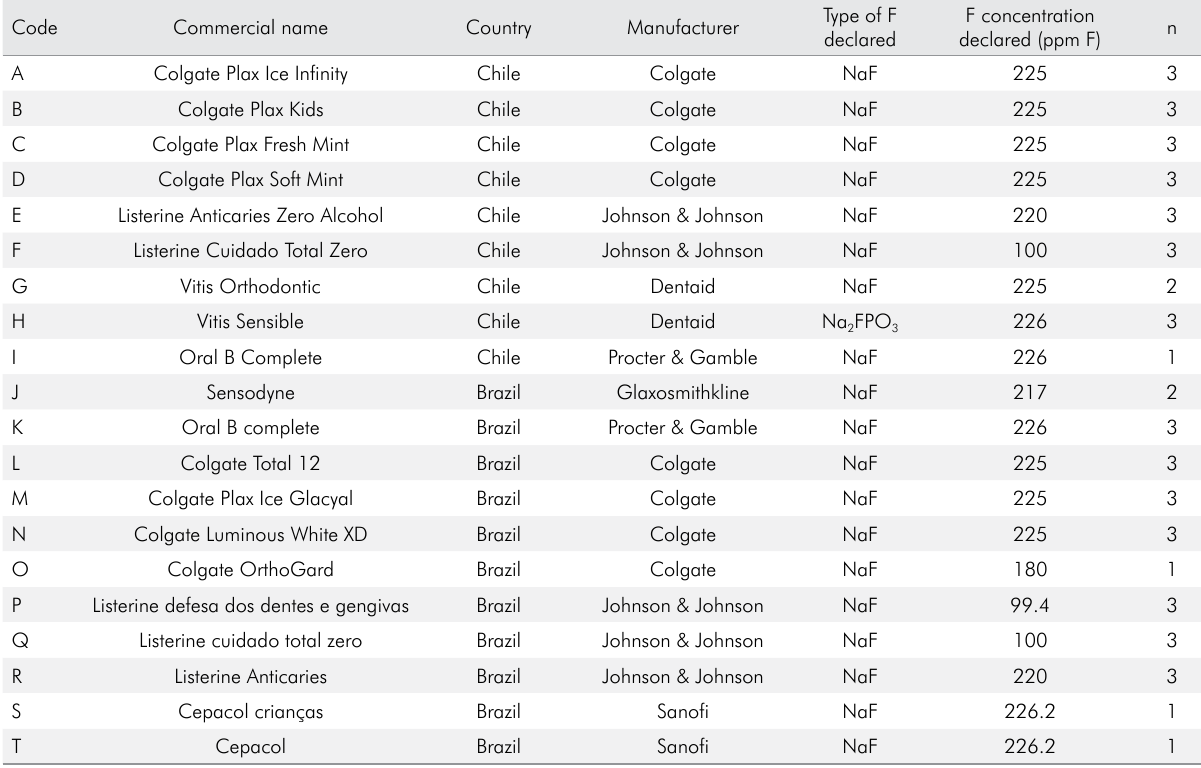
Table 1. Mouthwash information declared on the label of the